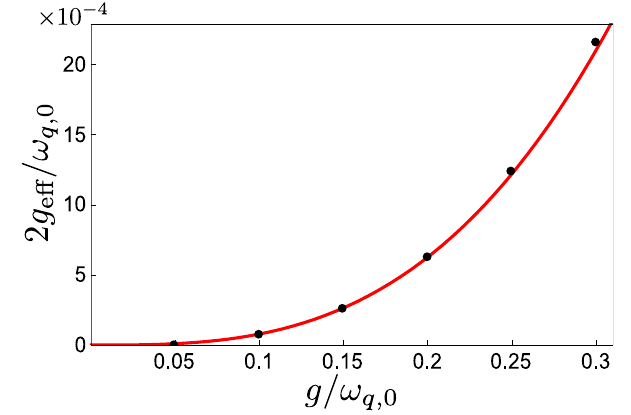
Figure 7. Comparison of analytical (red curve) and numerical (black dots) results for the effective coupling between the states |1, 0, g 〉 and |0, 2, e 〉 . The graph shows the minimum energy splitting 2 g eff / ω q ,0 as a function of g / ω q ,0 , using the same parameters as in Fig.